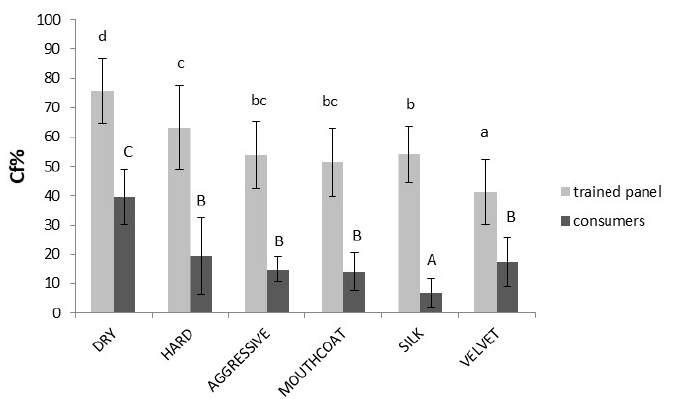
Figure 1. The average citation frequencies (Cf%) of the astringency subqualities in all Sangiovese wines ( n = 12) by trained panel and consumers. The upper letters indicate statistical differences in subqualities between the consumers and the lower letters between the trained panel ( p < 0.05).